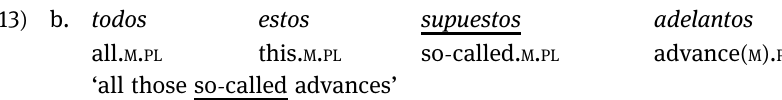
Table 1: Scope variation of dizque in twenty - fi rst - century texts a